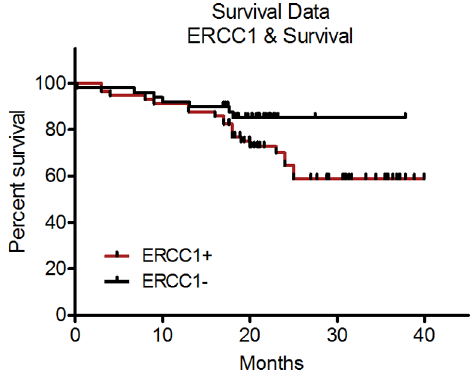
Figure 4. Adjuvant treatment did not significantly influence patient survival probability. Patient survival probability was not significantly influenced by platinum-based chemotherapy or radiation over no adjuvant therapy. Log-rank (Mantel-Cox) Test; Chi-square =2.0; p=0.56.